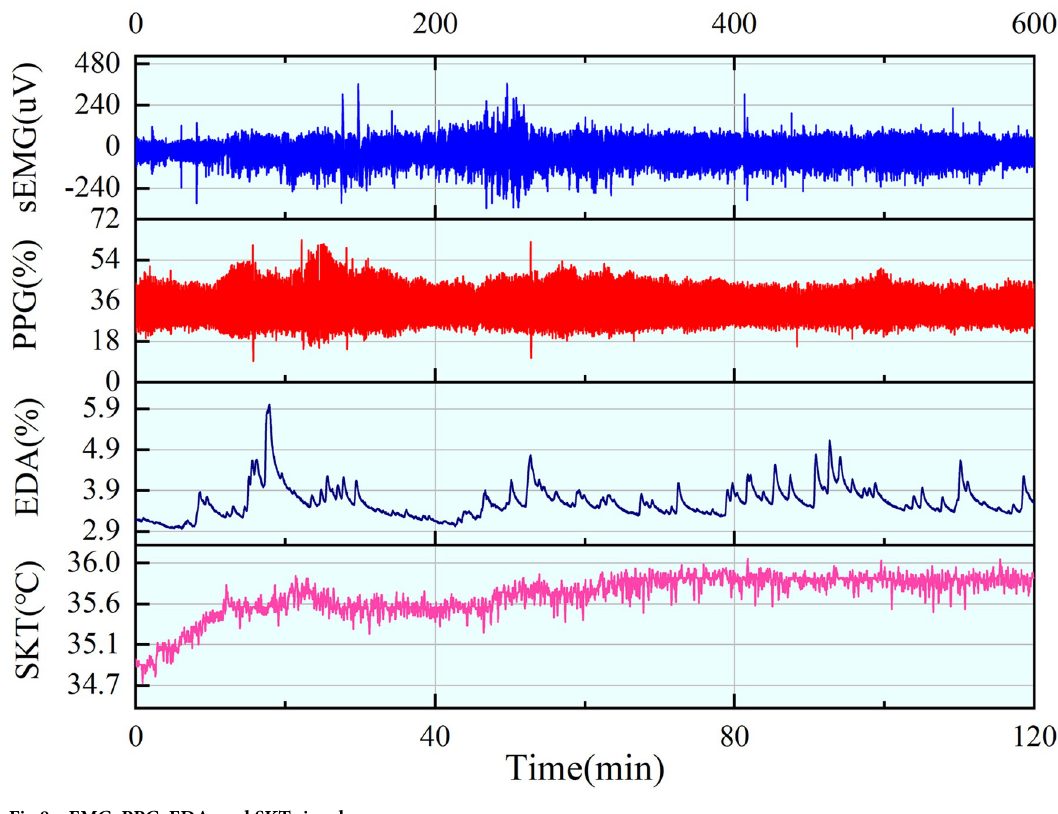
Fig 8. sEMG, PPG, EDA, and SKT